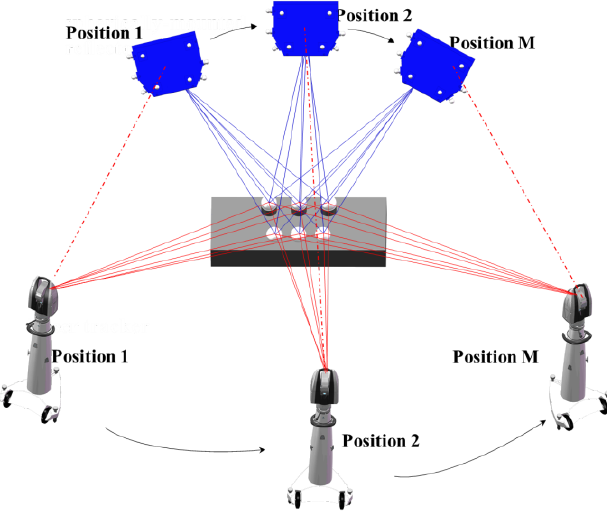
Figure 4. Schematic of the adjustment optimization.